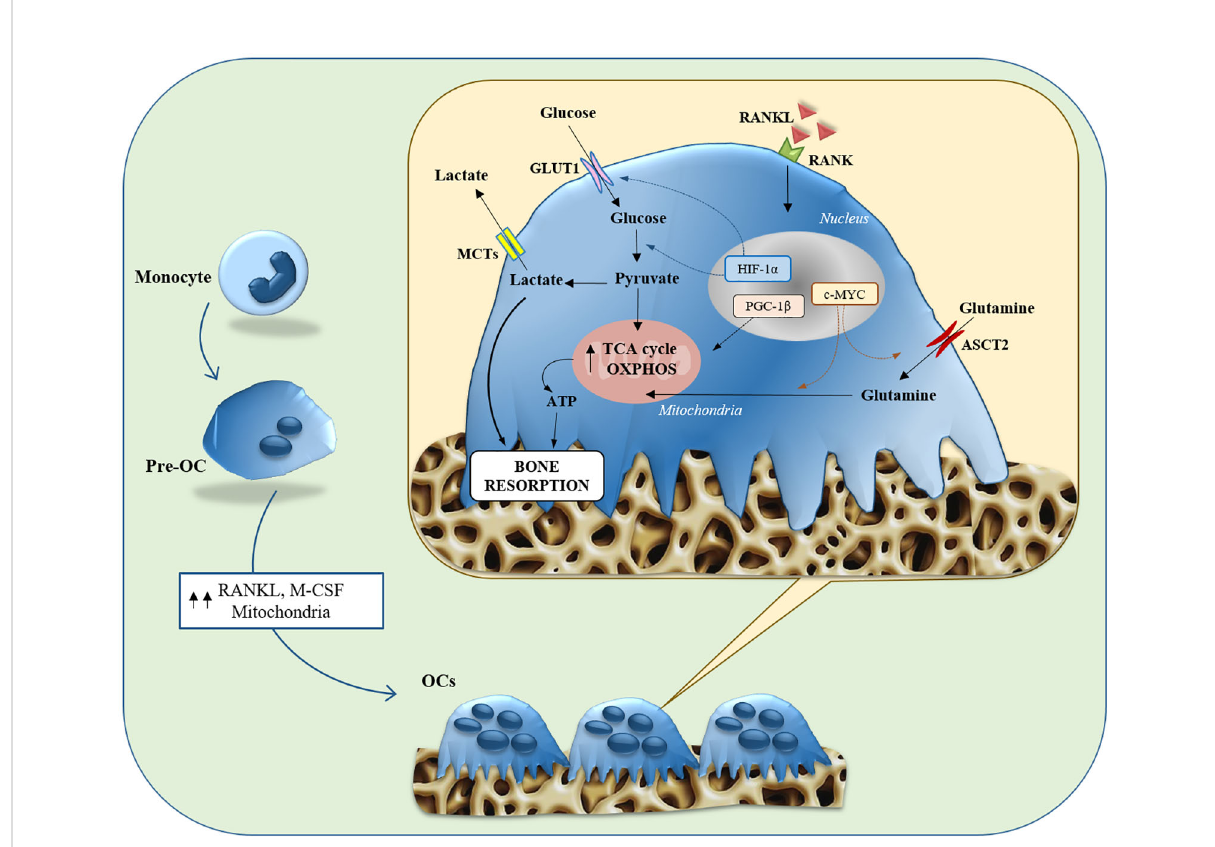
FIGURE 2 Glucose and glutamine metabolisms in Osteoclasts. Illustration summarizing both glycolysis and glutaminolysis in osteoclast differentiation and bone resorption function. Osteoclasts contain abundant mitochondria, whose biogenesis is stimulated by PGC-1 b , due to the bioenergetic demands of osteoclastogenesis and bone resorption. The expression of Glut1 and glycolytic genes is stimulated toward the maturation stage, through the action of HIF-1 a , contributing to bone resorption function. Expression of ASCT2 and glutaminase is induced via c-MYC in the early stages of differentiation, contributing to osteoclastogenesis and bone resorption function. ASCT2, alanine-serine-cysteine transporter; GLUT, glucose transporter; HIF1- a , hypoxia-inducible factor-alpha; M-CSF, macrophage colony-stimulating factor; MCT, monocarboxylate transporter; OC, osteoclast; OXPHOS, oxidative phosphorylation; PGC-1 b , peroxisome proliferator-activated receptor gamma coactivator 1- b ; RANK, receptor activator of nuclear factor-kappa B; RANKL, receptor activator of nuclear factor kappa-B ligand; TCA, tricarboxylic